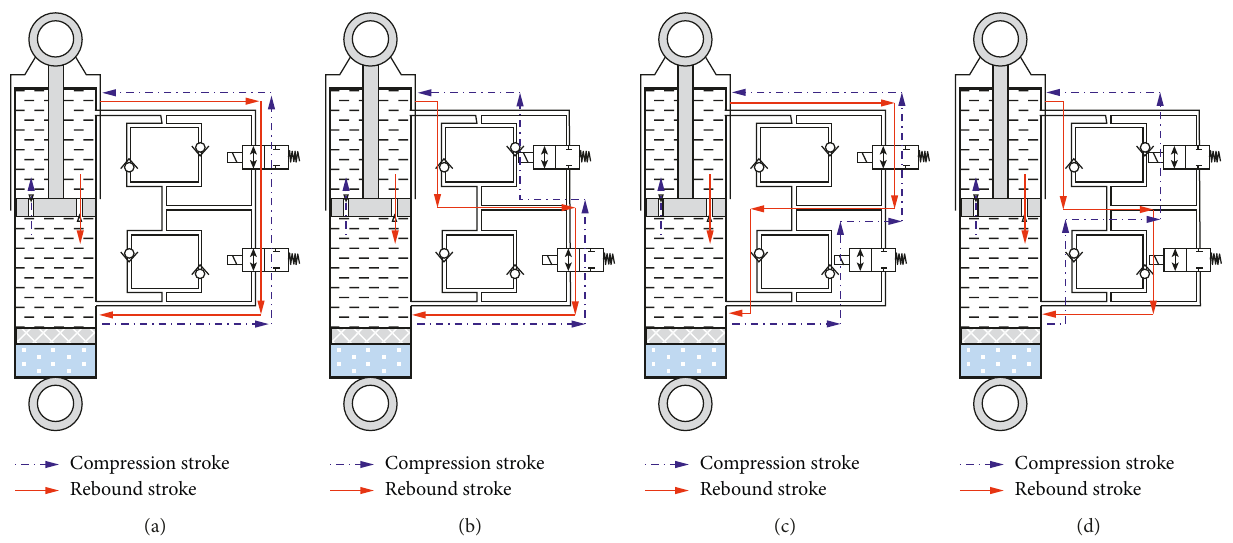
Figure 3: Oil flow paths of the four discrete damping modes (a) 1, (b) 2, (c) 3, and (d)